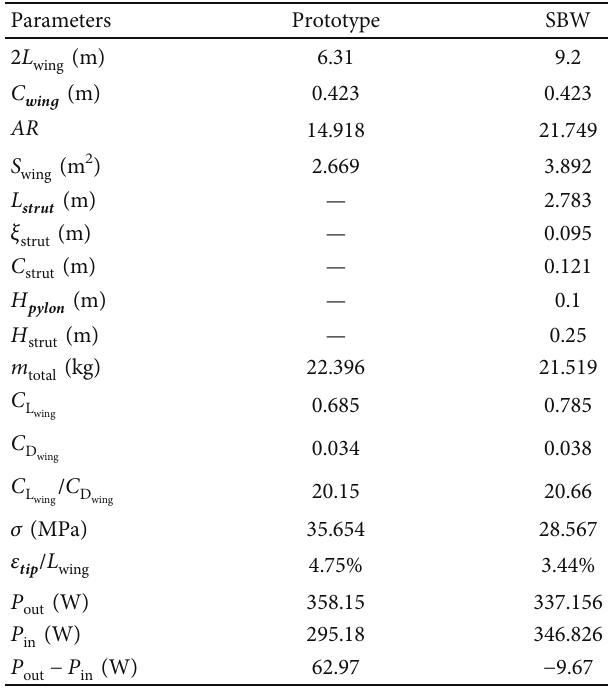
Table 7: The comparison between the SBW and the prototype.